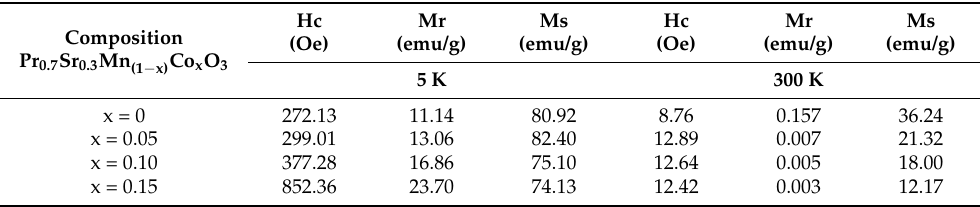
Table 6. Values of saturated magnetization (Ms), coercivity Hc and residual magnetization Mr, at 5 K and 300 K for samples Pr 0.7 Sr 0.3 Mn ( 1 − x ) Co x O 3 (0 ≤ x ≤